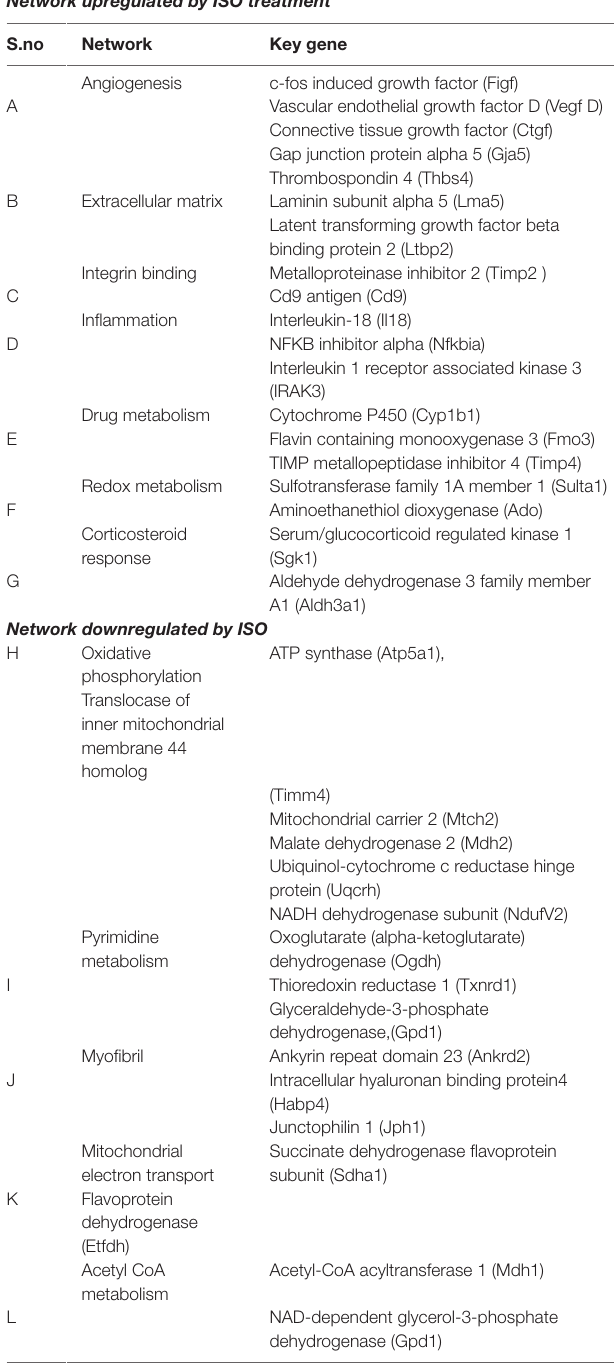
TABlE 2 | List of networks extracted from GeneMANIA after ISO treatments along with key genes are indicated. Network upregulated by ISO treatment